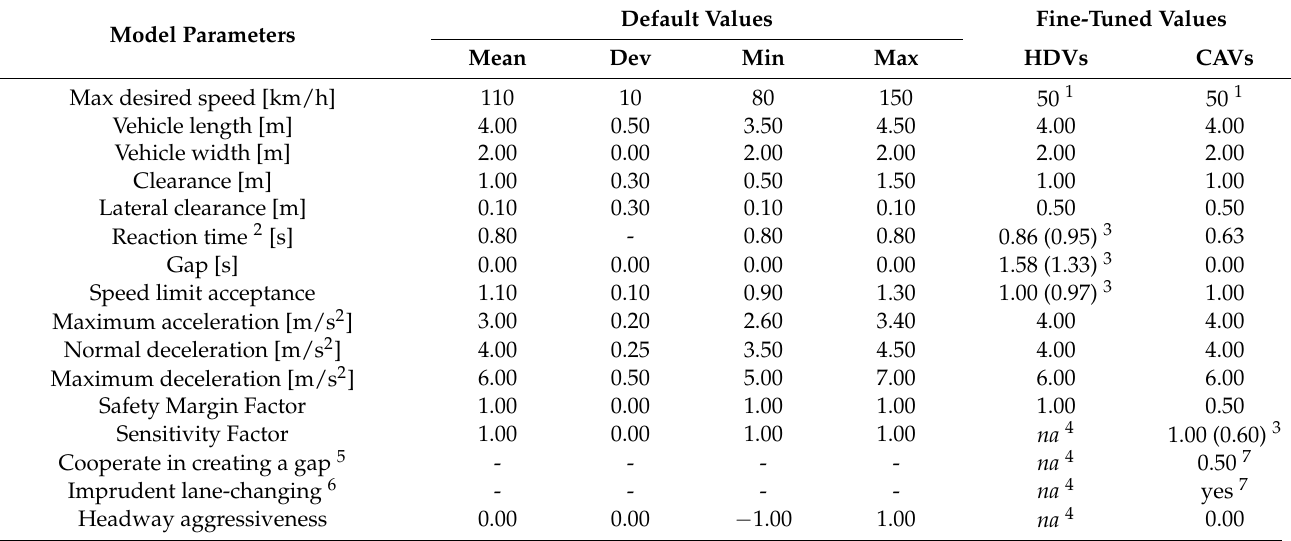
Table 2. Vehicle modelling parameters of Aimsun Next for the study roundabouts. Own research based on the default data presented in